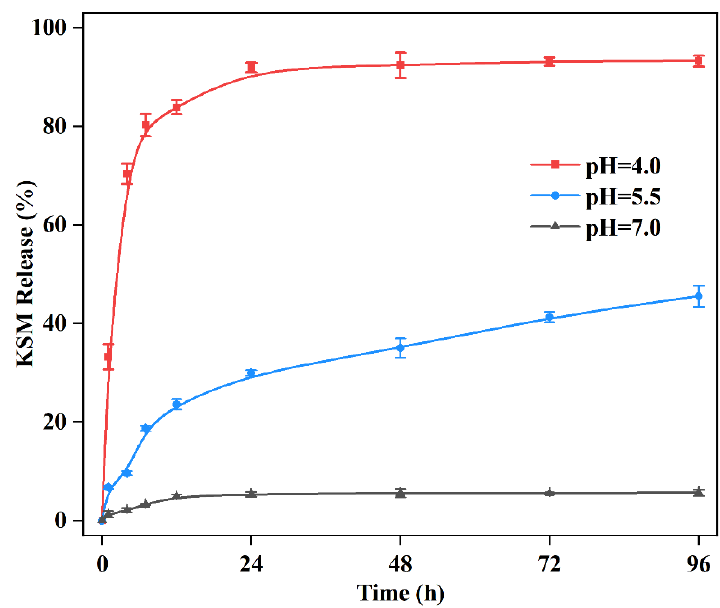
Figure 5. Effects of pH values on the release performances of KSM from ZIF-90-KSM. To further investigate the release kinetics of KSM from ZIF-90, the data were fitted to Table 2. Determined parameters of KSM released from ZIF-90-KSM by fitting several kinetic equa- tions. five different kinetic models. The fitted parameter values were presented in Table 2. For the effects of pH values, the controlled-release kinetics of KSM best fitted with the Higuchi model. Thus, the release of KSM was governed by Fickian